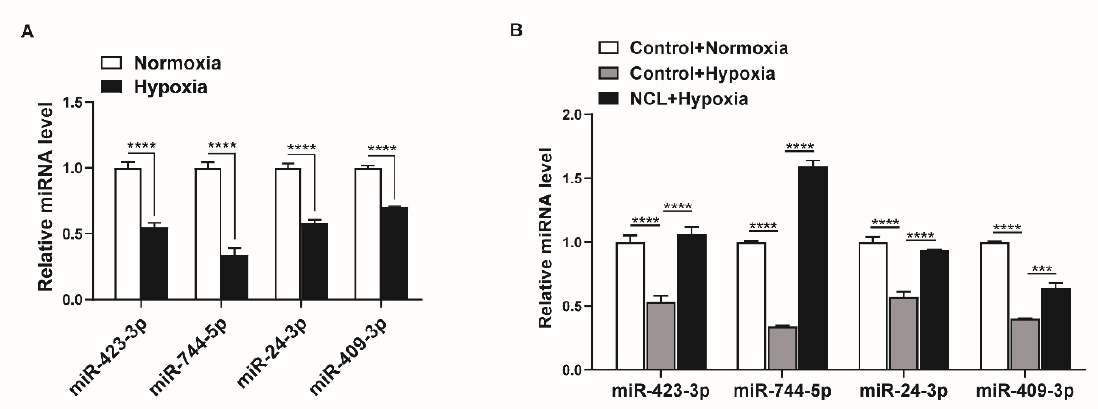
Figure 5. NCL is responsible for the hypoxia-induced downregulation of specific miRNAs. ( A ) Levels of miRNAs relative to U6 snRNA measured by qRT − PCR in PASMCs exposed to hypoxia for 24 h. The data represent the mean ± S.E. of triplicate measurements of three independent experiments. ( B ) Levels of miRNAs relative to U6 snRNA measured by qRT-PCR in NCL − overexpressing PASMCs after exposure to hypoxia for 24 h. The data represent the mean ± S.E. of triplicate measurements of three independent experiments. Statistical analyses were performed using two − way ANOVA Sidak’s multiple comparisons test ( A , B ). ***, p < 0.0005; ****, p < 0.0001.